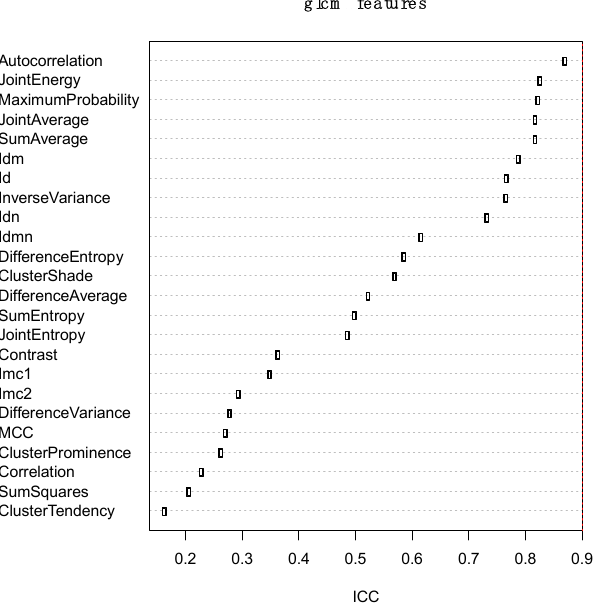
Figure 4. Robustness of second-order GLCM features across segmentations. Pyradiomics computes 24 second-order GLCM features. The robustness (ICC) is above 0.8 per all values of distance, only for Autocorrelation, Idn, Idmn, SumAverage, JointAverage, InverseVariance, JointEnergy, MaximumProbability, Id and Idm. Robustness of many features across segmentations is dependent on bin-width and distance (the vertical dashed red line on the right indicates the 0.9 threshold).